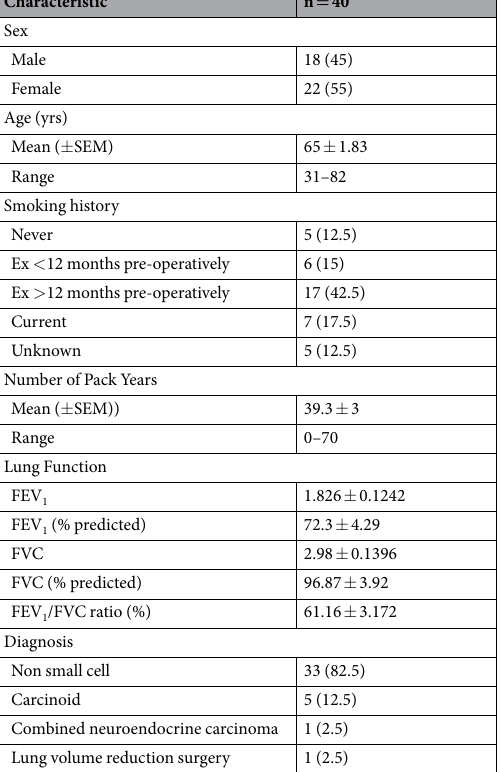
Table 2. Demographics of tissue donors. Note: data presented as n (%) or mean ± SEM. Abbreviations: FEV1, forced expiratory volume in 1 second; FVC, forced vital